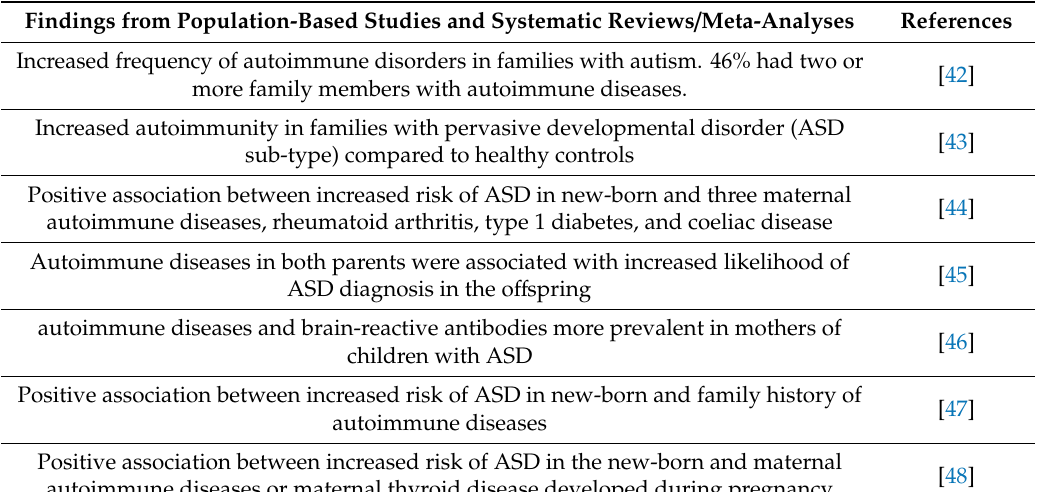
Table 1. Observational studies reporting an association between autoimmune diseases and ASD. Findings from Population-Based Studies and Systematic Reviews /